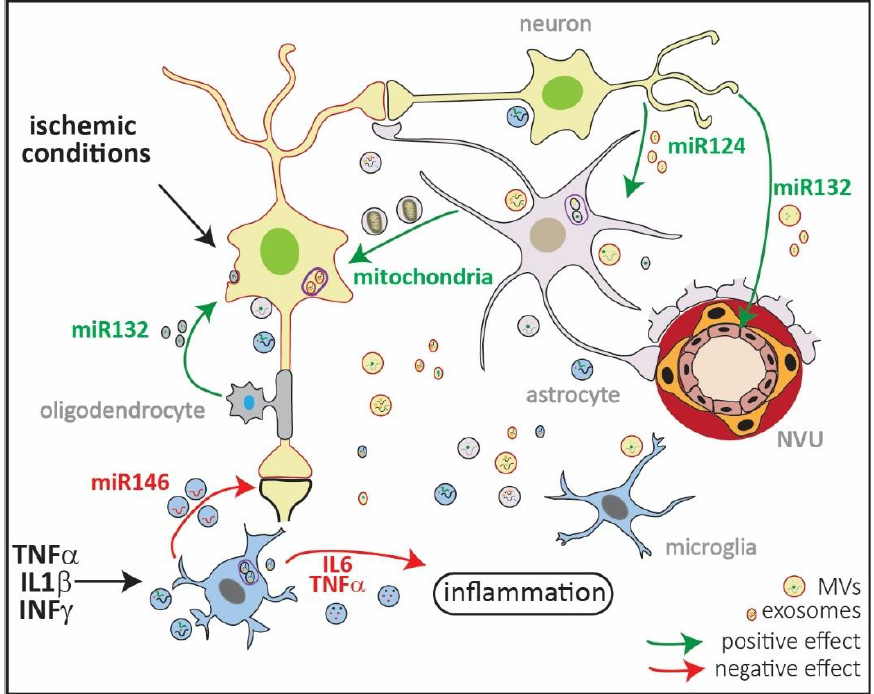
Figure 2. Schematic representation of extracellular vesicles (EVs) in ischemic injury. EVs comprise microvesicles (MVs) ranging from 0.1–1 µm, exosomes ranging from 30–150 nm, and ApoEVs ranging from 0.8–5 µm (Figure 1). They all have a different cellular origin, with MVs shed from the plasma membrane, while exosomes are formed in multivesicular endosomes (MVEs; in violet). All types of brain cells produce exosomes and MVs, which transport lipids, DNA, mRNA, miRNA, and proteins loaded in a stimulus-dependent manner. Under in vitro ischemic conditions, exosomes released by oligodendrocytes contain miR132 which are taken up by neurons and promote their survival [92,93]. By contrast, EVs released by microglia previously exposed to lipopolysaccharide (LPS) increase in size and content of IL6 and TNFα, thus exacerbating inflammation [92,93]. Microglia exposed to proinflammatory cytokines increase the release of miR146 via exosomes that are taken up by neurons, downregulating synaptotagmin 1 and neuroligin 1 and contributing to loss of excitatory synapsis [92,93]. Neurons can contribute to endothelial integrity and, thus, to the neurovascular unit (NVU) functionality by releasing miR132 in EVs. Neurons can also regulate the expression of GLT1 in astrocytes through vesicular miR124 [92,93]. Finally, it has been shown that astrocytes can release mitochondria in MVs, which contributes to neuronal survival in in vitro and in vivo models of ischemia [92,93]. The content of the exosomes and MVs in the picture is random and only depicts the variety of EV cargos.